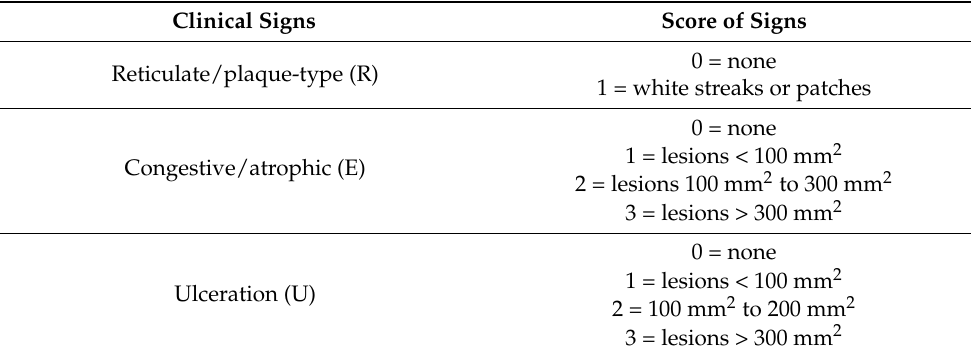
Table 2. Scores of REU signs of oral lichen planus [13].